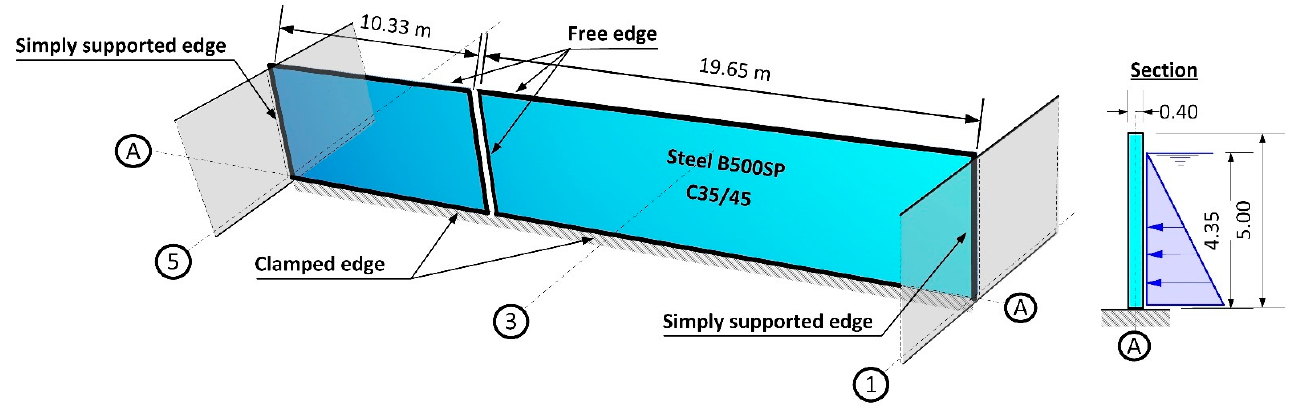
Figure 4. Static scheme adopted in the project design for walls on the A axis for the leak testing of the biological reactor.